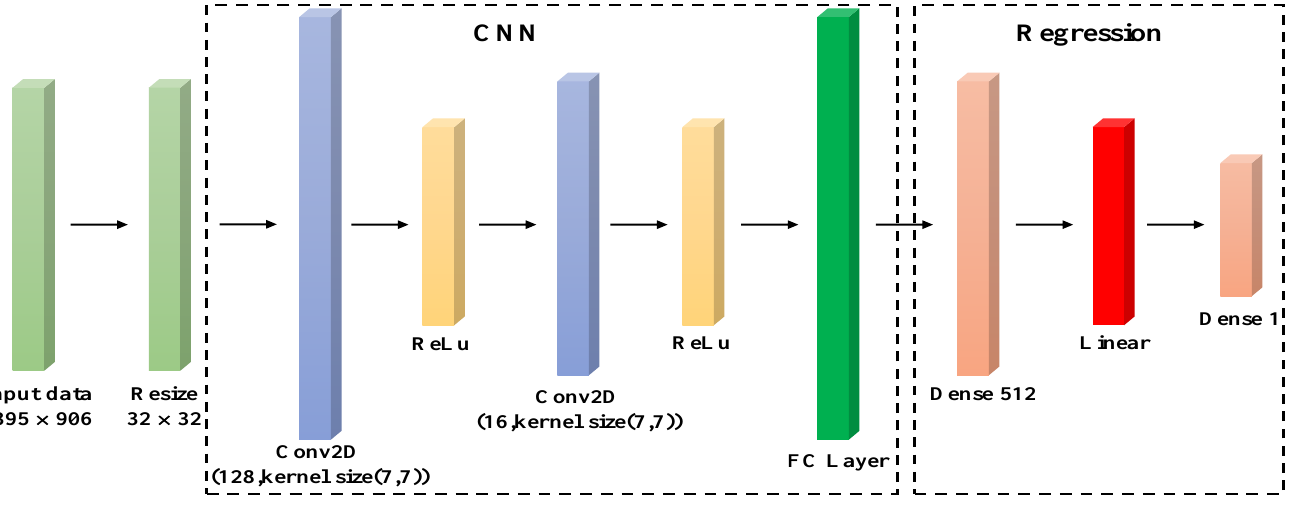
Figure 5. The architecture of CNN-R. Table 1. The settings of the training option used in the single acoustic